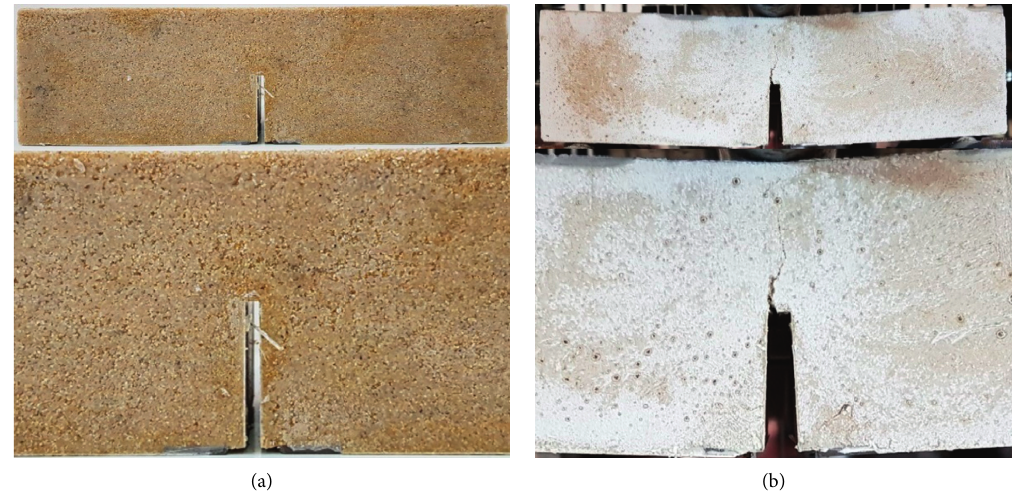
Figure 14: Picture of the tested specimens with brittle and ductile responses.